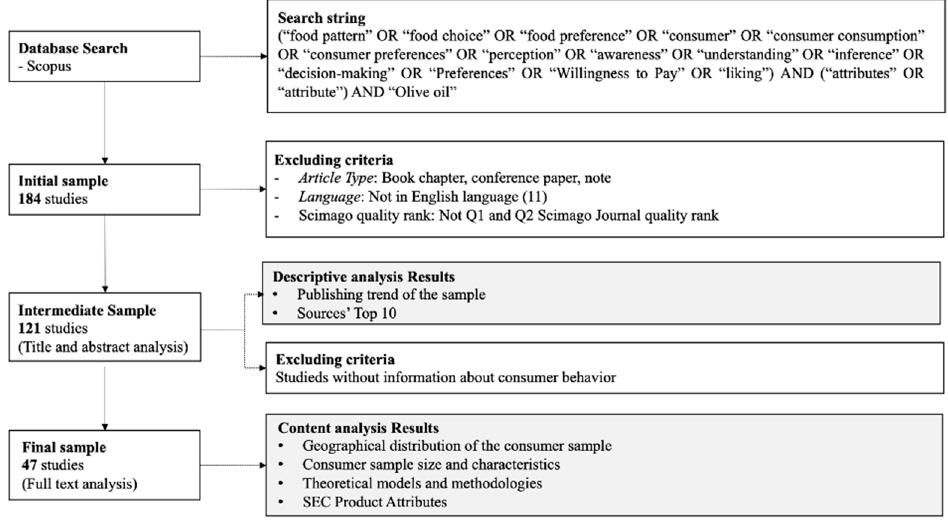
Figure 1. Research methodology.